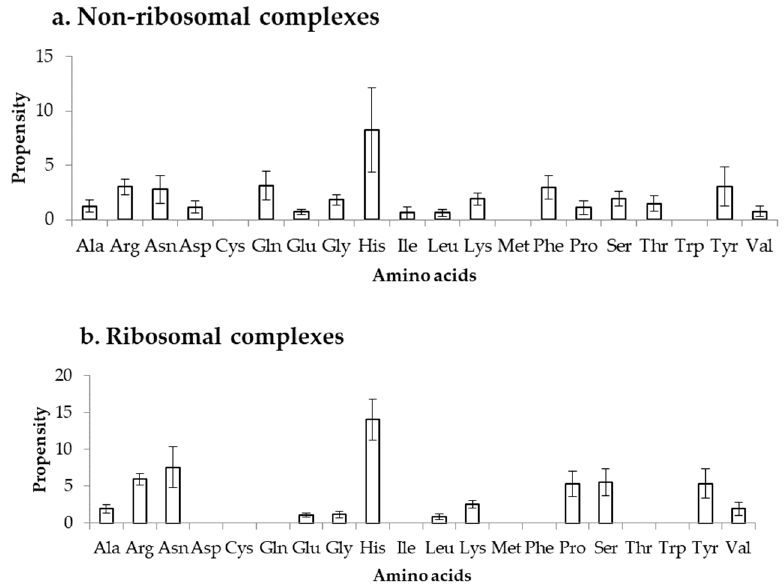
Figure 5. Propensity for amino acids in ( a ) non-ribosomal and ( b ) ribosomal complexes.